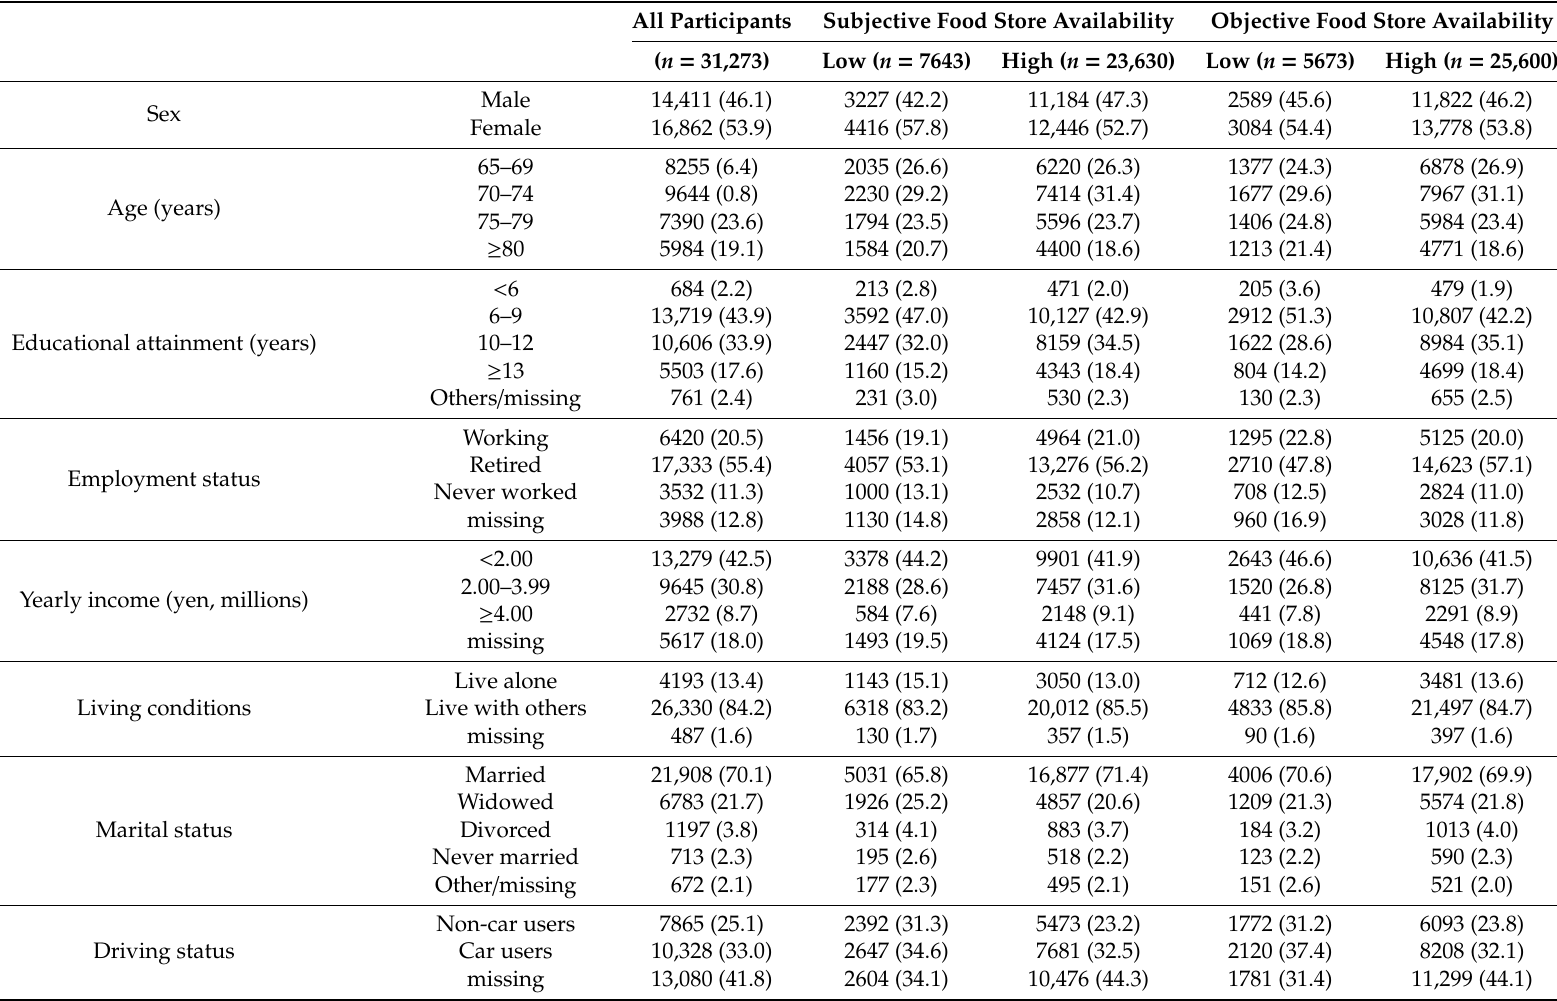
Table 1. Baseline characteristics of participants and incidence of functional disability after 6